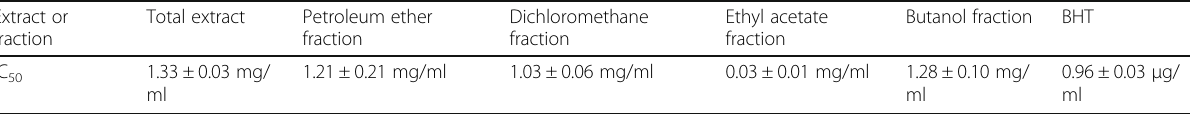
Table 4 Results of the free radical scavenging activities of the total ethanol extract and the different fractions of C. myxa L. leaves using DPPH assay Extract or Total fraction